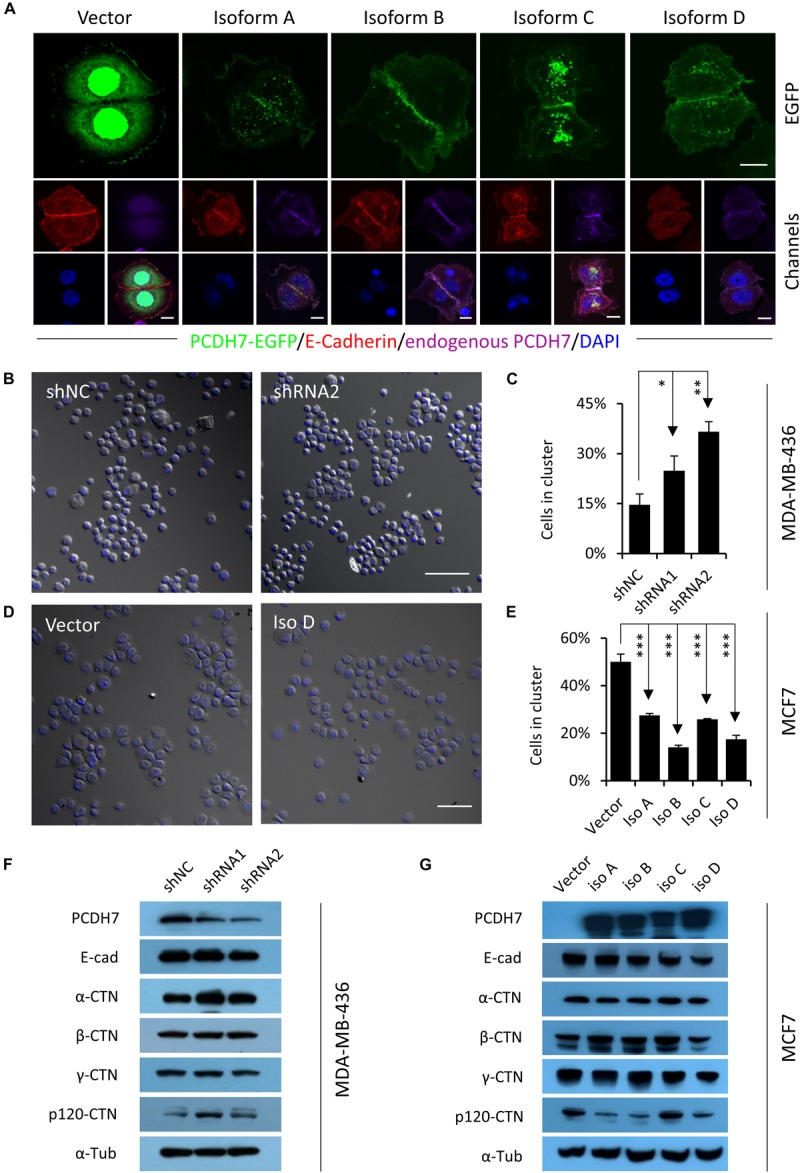
PCDH7 inhibits intercellular adhesion. (A) Subcellular localization of PCDH7 isoforms in MCF7 cells. Cells expressing EGFP-tagged PCDH7 isoforms (green) were stained with anti-E-cadherin (red) and anti-PCDH7 (purple) antibodies. Scale bars: 10 μm. (B) Representative images for cluster formation of PCDH7-depleted MDA-MB-436 cells. The nuclei were stained with DAPI. Scale bar: 100 μm. (C) Quantification of cells forming clusters in PCDH7-depleted MDA-MB-436 cells. Data are mean ± SD of triplicate experiments. ∗P < 0.05; ∗∗P < 0.01. (D) Representative images for cluster formation of MCF7 cells overexpressing PCDH7D. The nuclei were stained with DAPI. Scale bar: 100 μm. (E) Quantification of cells forming clusters in MCF7 cells overexpressing PCDH7. Data are mean ± SD of triplicate experiments. ∗∗∗P < 0.001. (F,G) Expression of adhesion molecules upon PCDH7 depletion (F) or overexpression (G) as detected by Western blot.